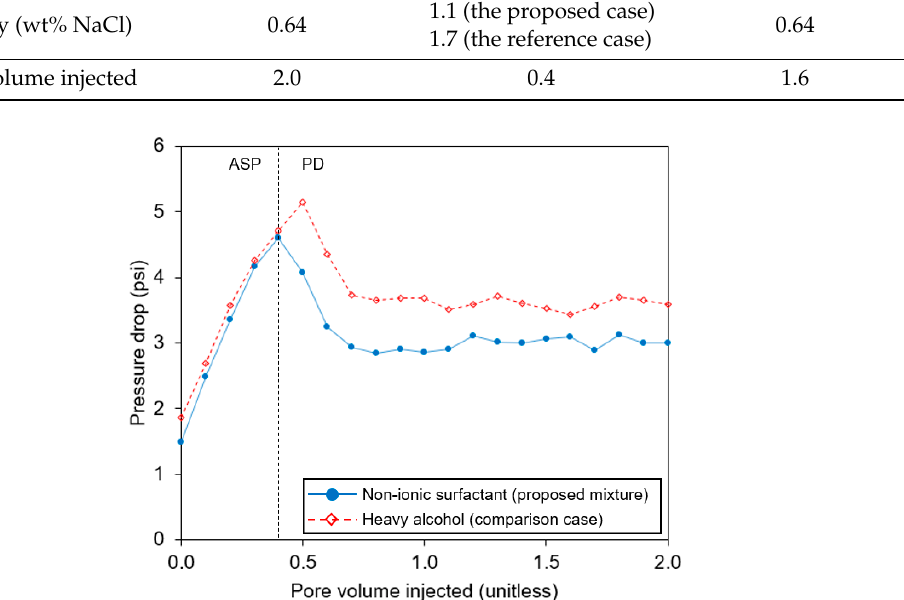
Figure 5. Plot of the pressure drop measured during the coreflooding tests. Figure 6 compared the oil cut and the cumulative oil recovery after pre-flush. The cumulative oil recovery of the nonionic surfactant addition was about 74% of the residual oil after waterflooding, while that of the comparison remained at 51%. The oil cut of the proposed mixture showed a late-